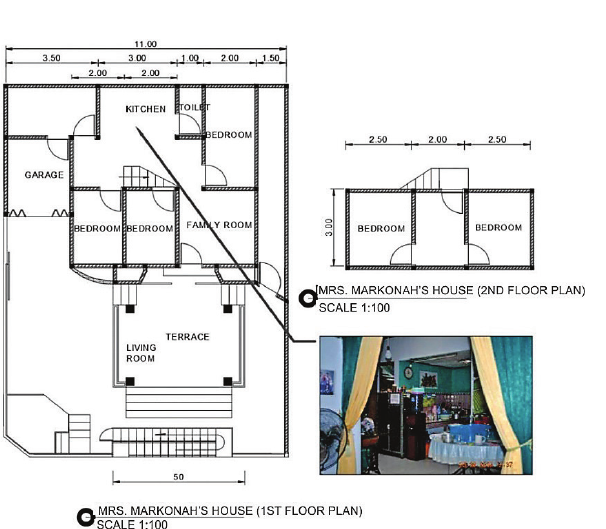
Figure 8. Kitchen as mix-use space in Figure 9. Living room and Kitchen as mix-use production